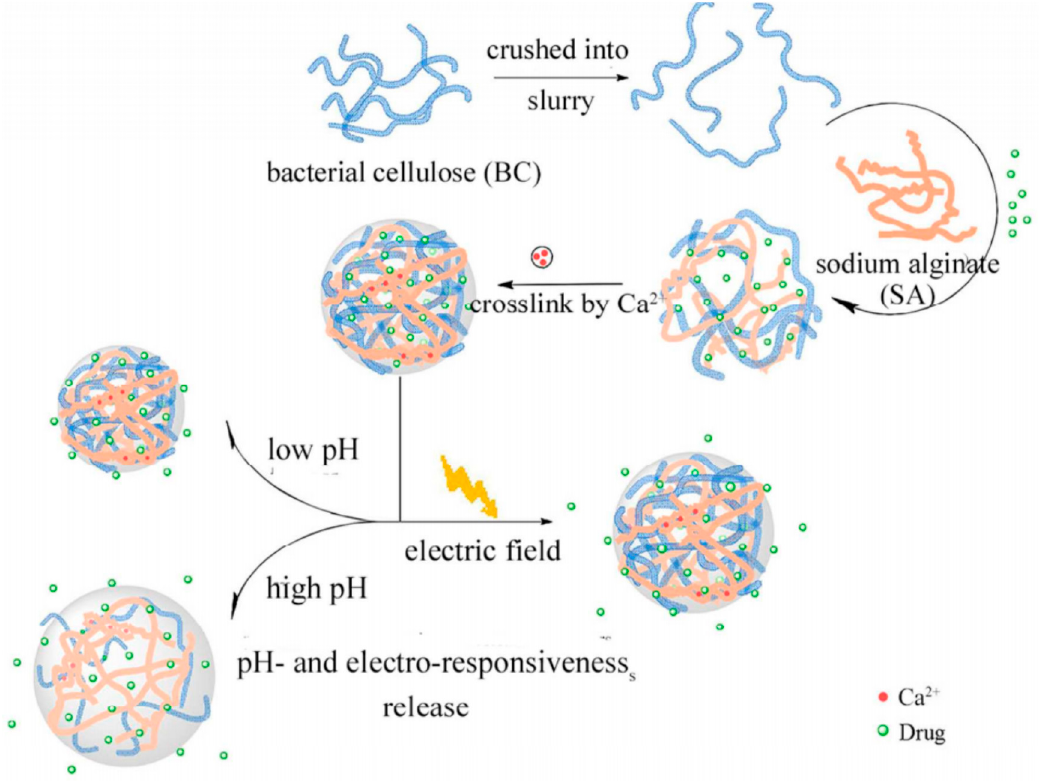
Figure 10. Releasing process for the drug loaded bacterial cellulose nanofiber and sodium alginate (nf-BC / SA) hybrid hydrogels under di ff erent pH and in various electric field strengths [107].